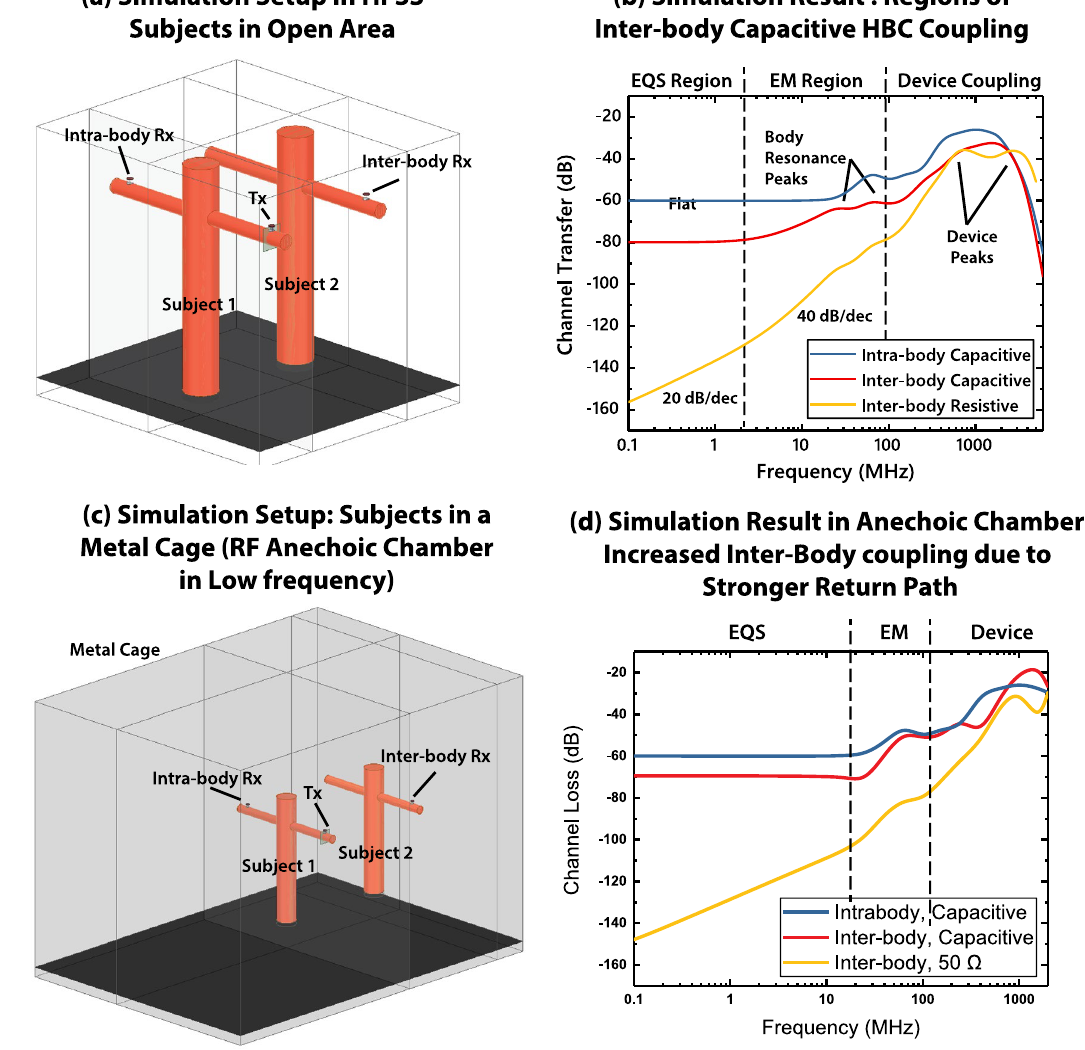
( c ) Simulation setup for results in Anechoic Chamber. The subjects are enclosed in a metal-cage to represent higher return-path coupling in EQS region. This simulation setup is used to validate experimental results from EQS region in the anechoic chamber. ( d ) HFSS simulation results, inside anechoic chamber. The EQS region of the inter-body responses, are 10 dB higher compared to open air simulation results in 5b. Because of this, the transition point between EQS region and EM region moves